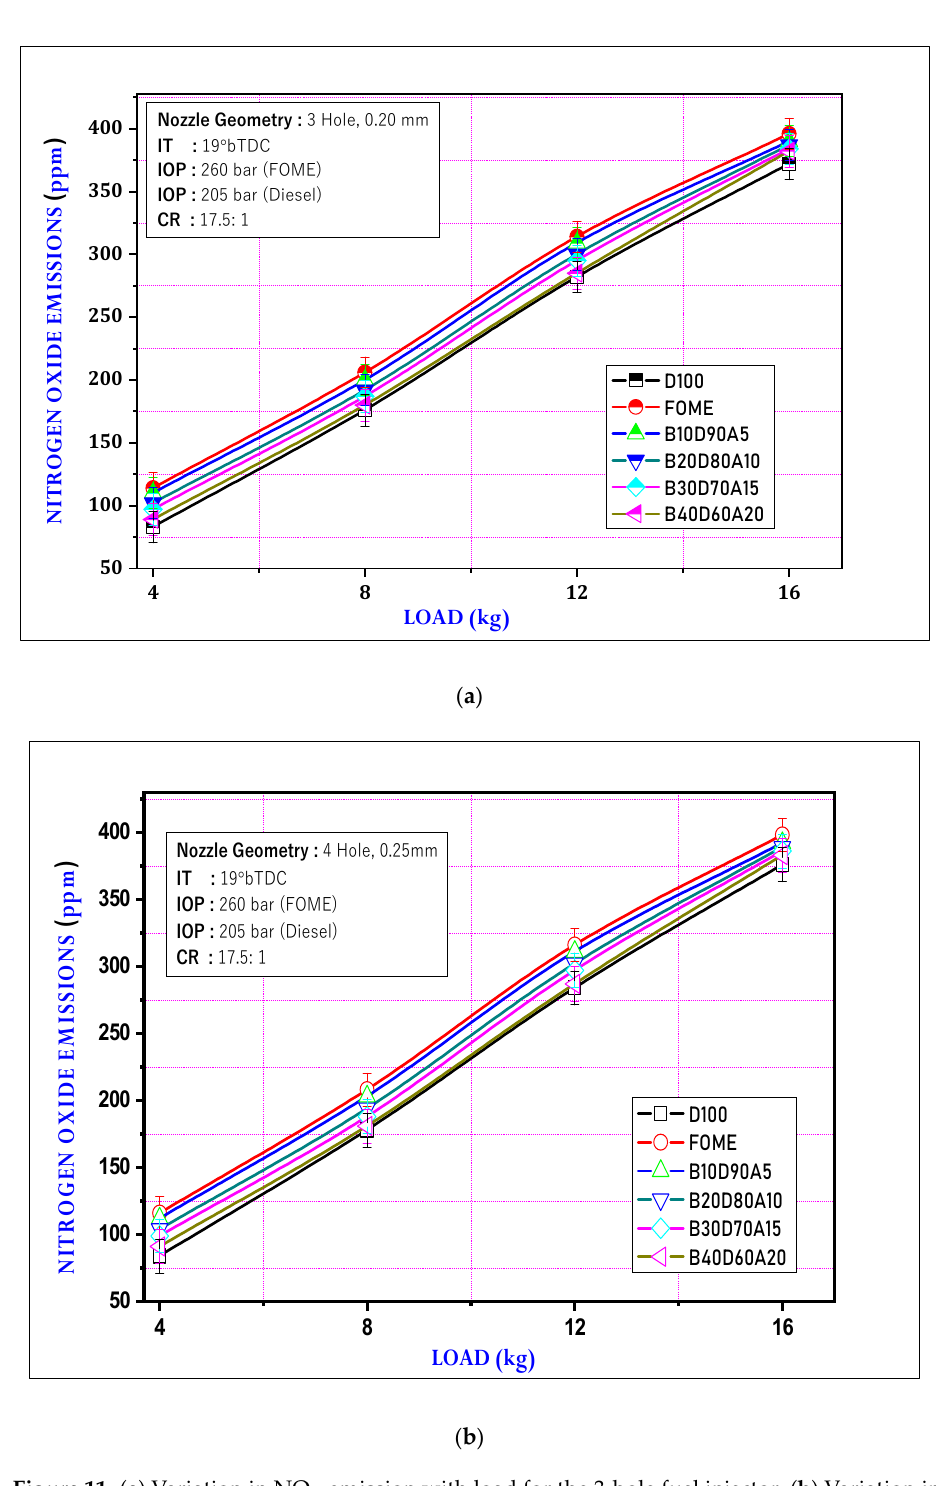
Figure 11. ( a ) Variation in NO X emission with load for the 3-hole fuel injector. ( b ) Variation in NO X emission with load for the 4-hole fuel injector.